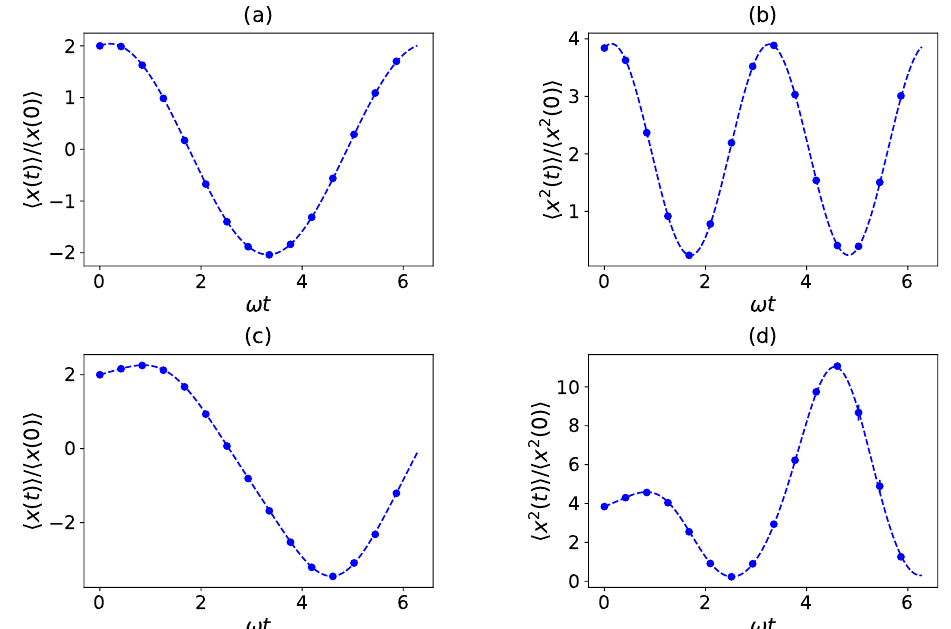
Figure 4: Time evolution of the expected (a) position 〈 x 〉 and (b) squared position 〈 x 2 〉 of a Gaussian wave packet with σ = 0.5, k = 1.0,, and a = 0.5, evolving ac- cording to Eq. (1) with m = 10, ω = 1, λ = 0.2. The dashed line corresponds to the numerics performed with the Crank-Nicholson method with space bin ∆ x = 10 − 5 and time step ∆ t = 10 − 3 , while the blue dots are computed with the stochastic method with ∆ t = 10 − 4 , and sampling N = 1.2 × 10 5 trajectories. The time t has been chosen such that t < 〈 t γ 〉 with 〈 t γ 〉 ≃ 27, and σ γ ≃ 19, see Fig. 2a-b . Similarly, panels (c) and (d) display the evolution of 〈 x 〉 and 〈 x 2 〉 , respectively, in the case of ω 2 ( t ) = ω 2 = 1, λ = 0.2, and 〈 t 〉 ≃ 31, sin 2 ( t ) and λ ( t ) = λ sin 2 ( t ) with ω γ 0 0 0 0 with σ γ ≃ 18, see Fig. 2c-d. As above, the dashed line corresponds to the nu- merics performed with the Crank-Nicholson method with space bin ∆ x = 10 − 6 and time step ∆ t = 10 − 3 , while blue dots are computed with the stochastic method with ∆ t = 10 − 4 , and sampling N = 1.2 × 10 5 trajectories. Error bars are given by statisti- cal standard deviation over the trajectories average and are only visible in panel